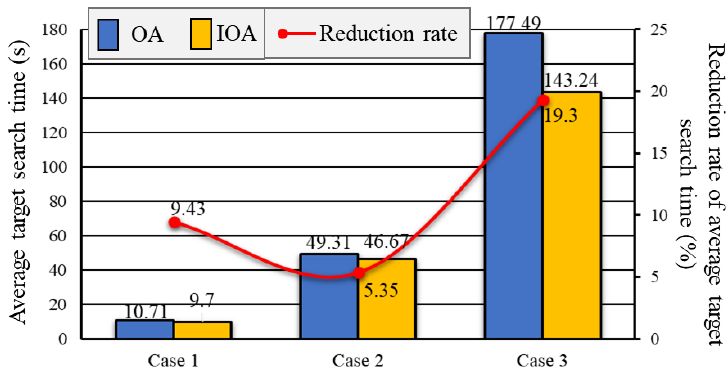
Figure 14. The distance reduction rate of path obtained by OA relative to RBA and GA.